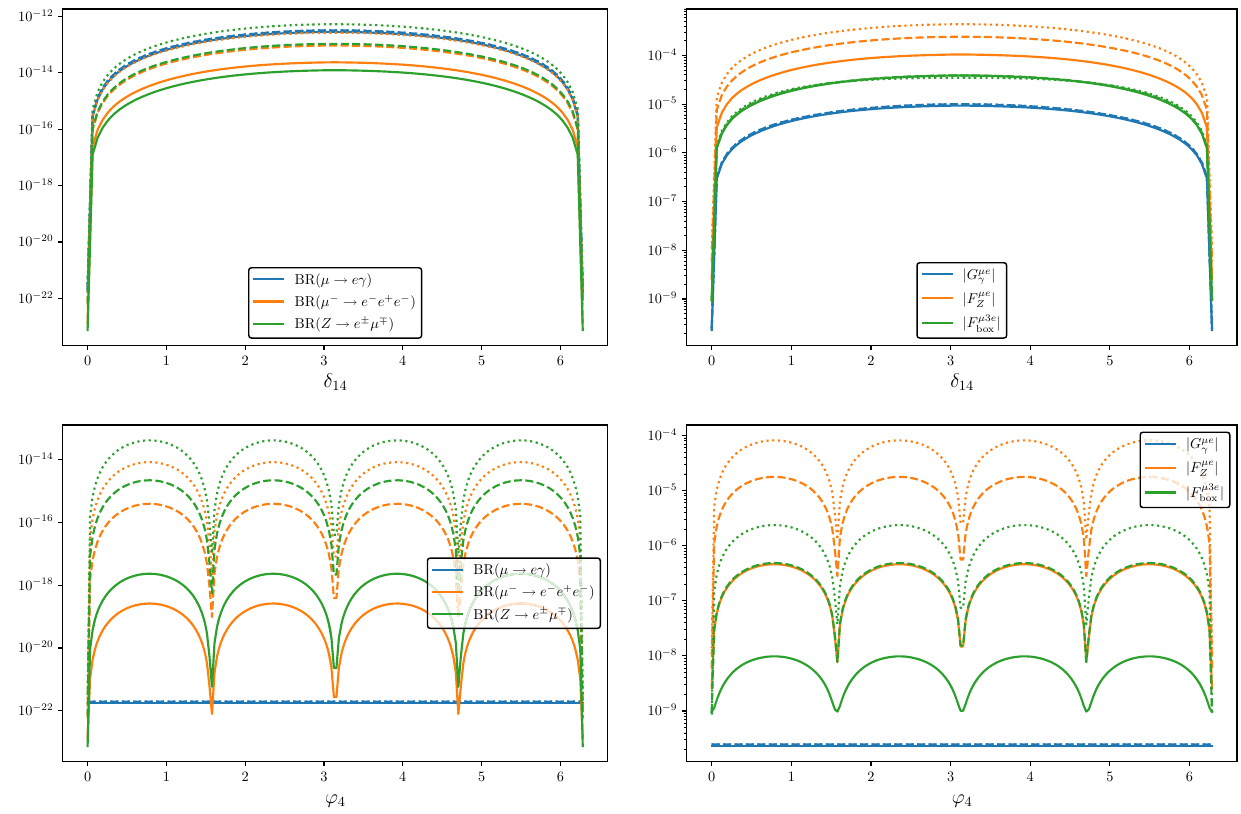
Fig. 11 Dependence of cLFV observables and several form factors (contributing to the different decay rates) on the CPV phases δ 14 and ϕ 4 , as done in Figs. 3 and 5, but with sin θ 15 = − sin θ 14 between the observables is strongly affected – if not lost,